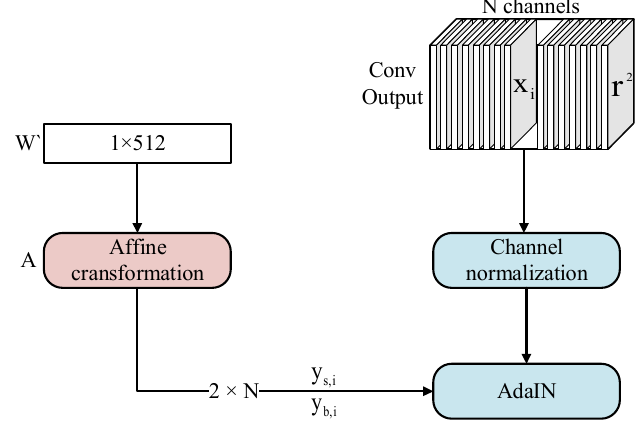
Figure 3. The implementation process of AdaIN.